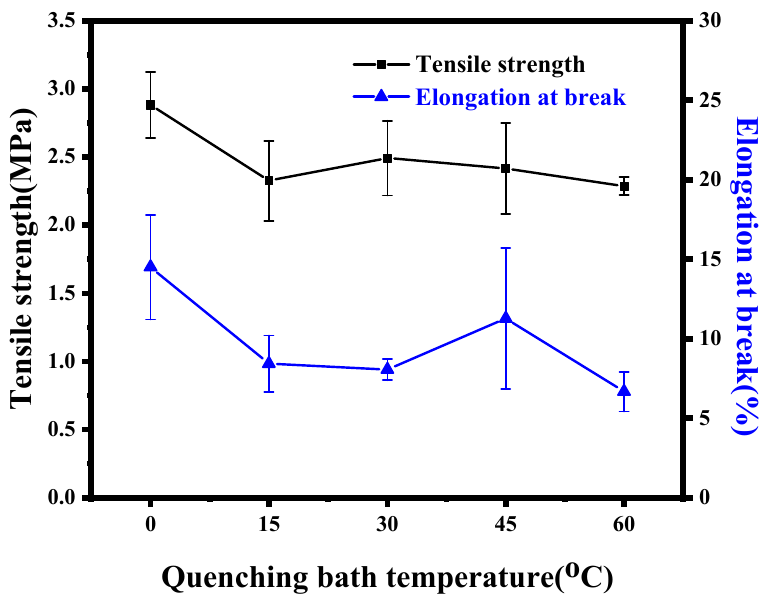
Figure 12. Mechanical properties of ECTFE membranes prepared at different cooling rates.